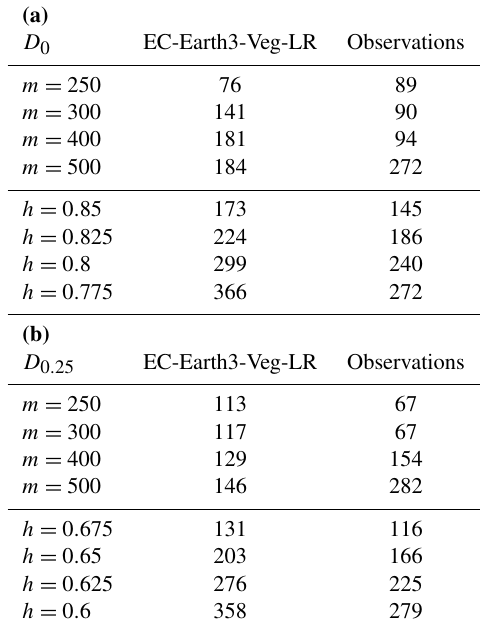
Table 2. The number of clusters for the EC-Earth3-Veg-LR climate model and the observational data determined with the L method ( m data) and the threshold method ( h data) for different ranges